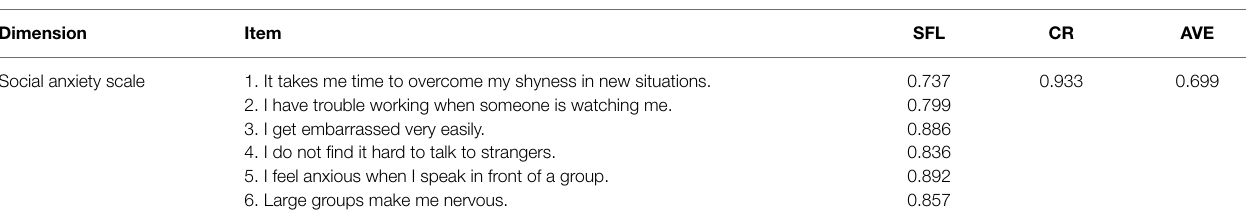
TABLE 3 | CFA of the social anxiety scale.